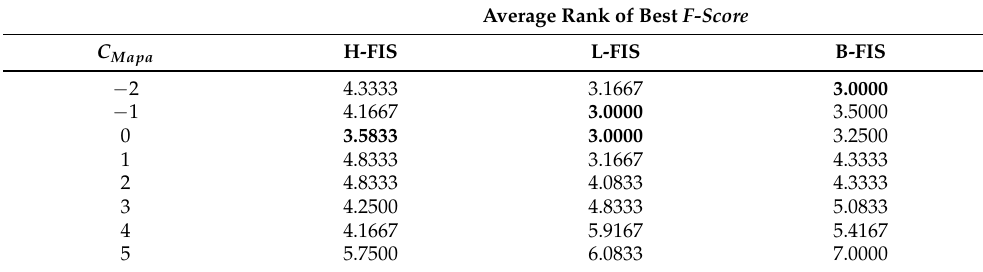
Table 11. Average rank of best F-Score for C Map constant.